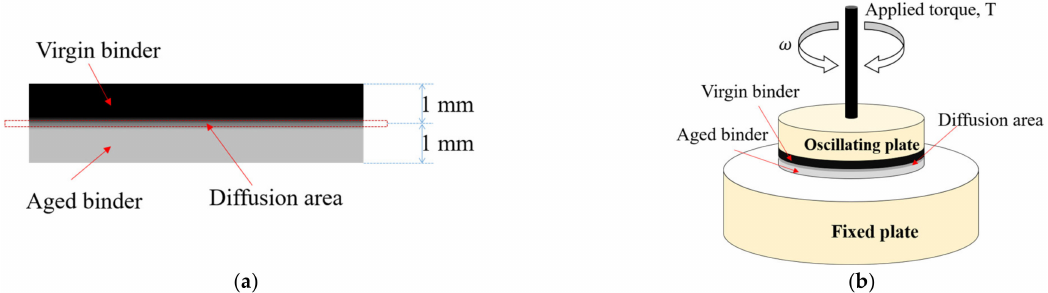
Figure 12. Schematic diagram of the composite binder in the DSR test. ( a ) two-layered composite binder; ( b ) Schematic diagram of DSR test.